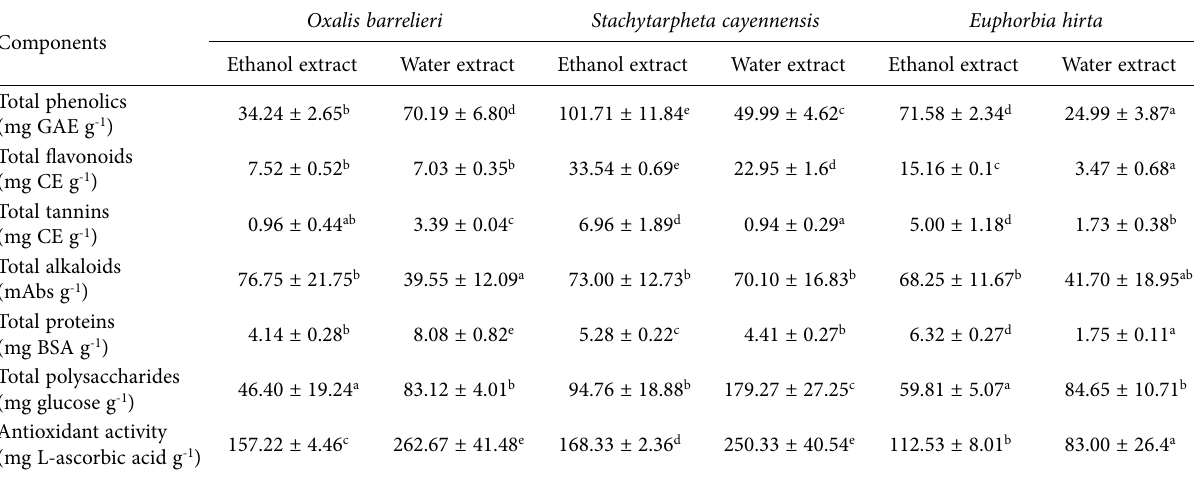
Table 2. Total phenolics, flavonoids, alkaloids, tannins, proteins, polysaccharides content, and antioxidant capacity of three tropical plant extracts from Oxalis barrelieri , Stachytarpheta cayennensis and Euphorbia hirta.